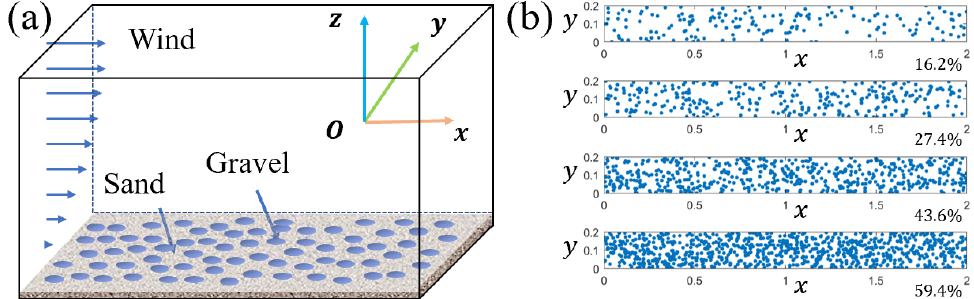
Figure 1. ( a ) Diagram of Gobi terrain setting. ( b ) Gravel distribution on the Gobi bed with different gravel cover in the numerical model, in which the blue dots is representative of the coverage